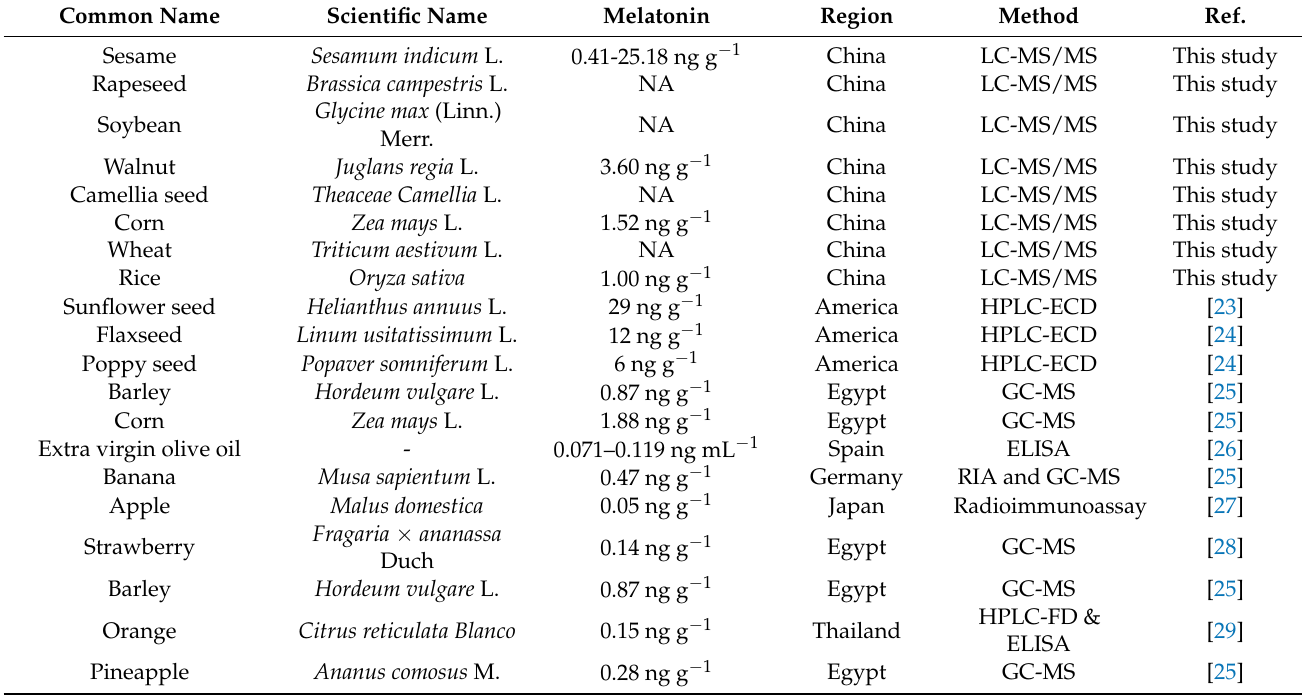
Table 1. The content of melatonin in plant-derived